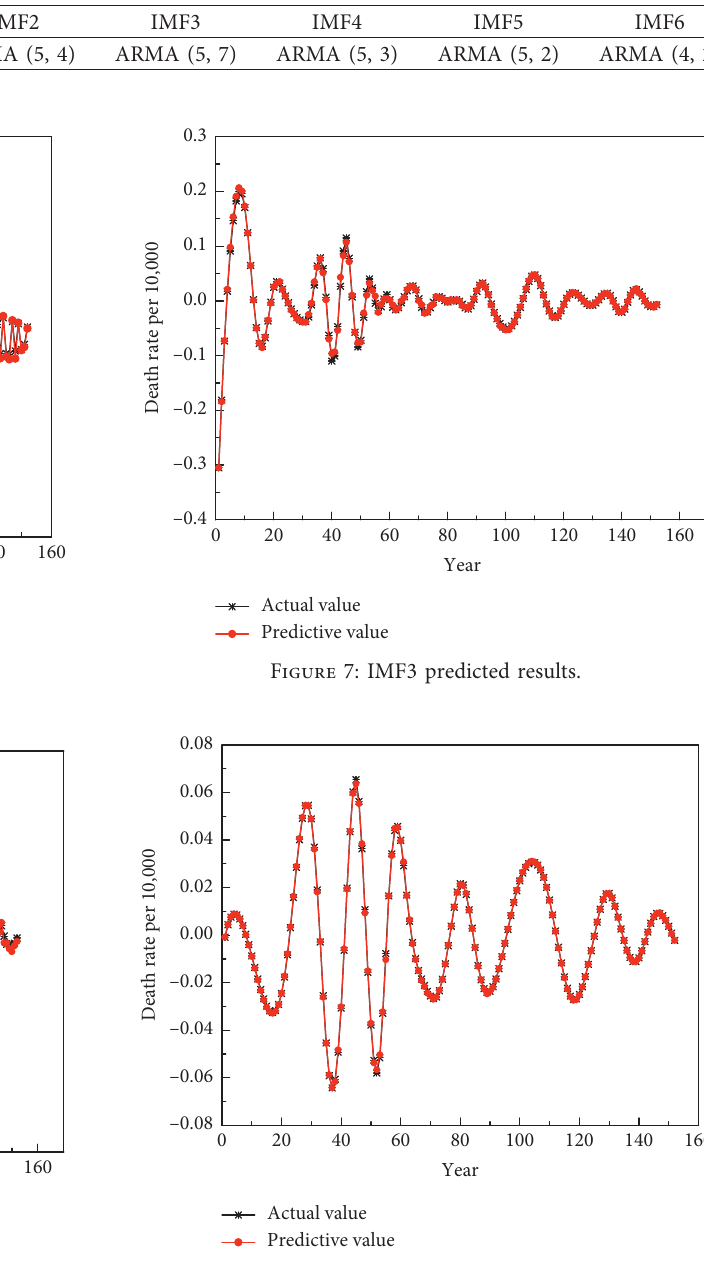
Figure 8: IMF4 predicted